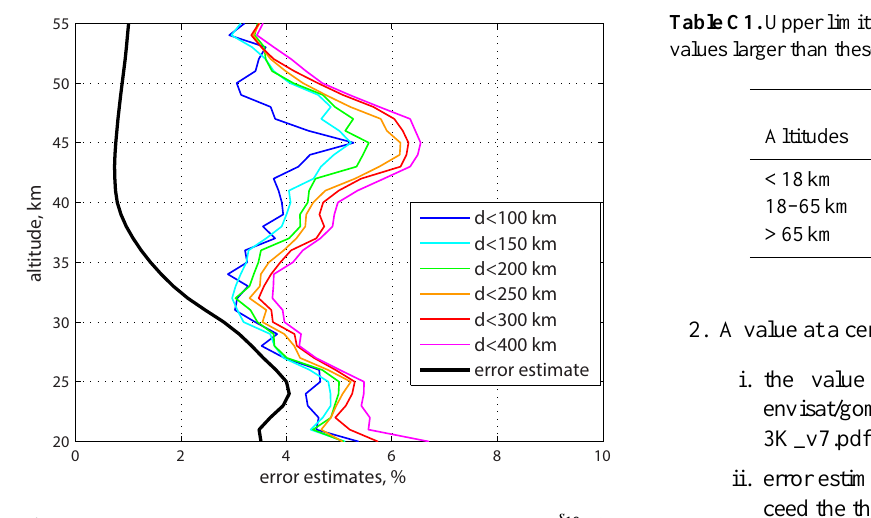
Figure B1. Color lines: experimental precision estimates s 12 √ different separation distances; black line: mean error estimate. GO- MOS self-collocations of star S30 occultations close to the North Pole in 2007–2008 are used.